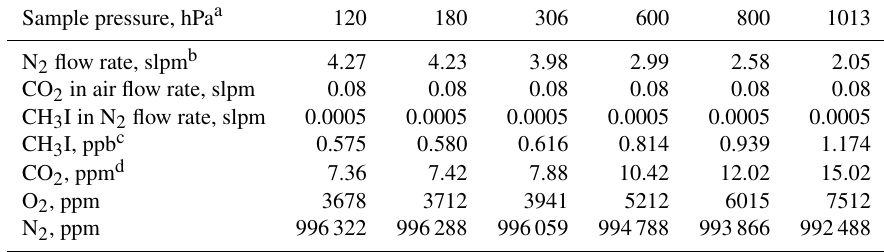
Table 2. Initial reagent gas flow rates and reagent gas mixing ratios at six sample air pressures.